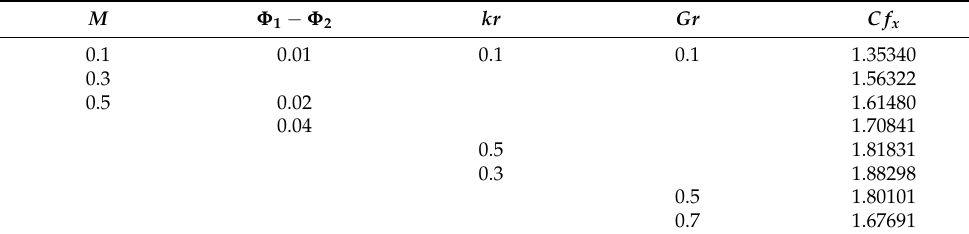
Table 3. Depenedence of Cf x Re 0.5 x values with the varying strength of associated quantities [44].